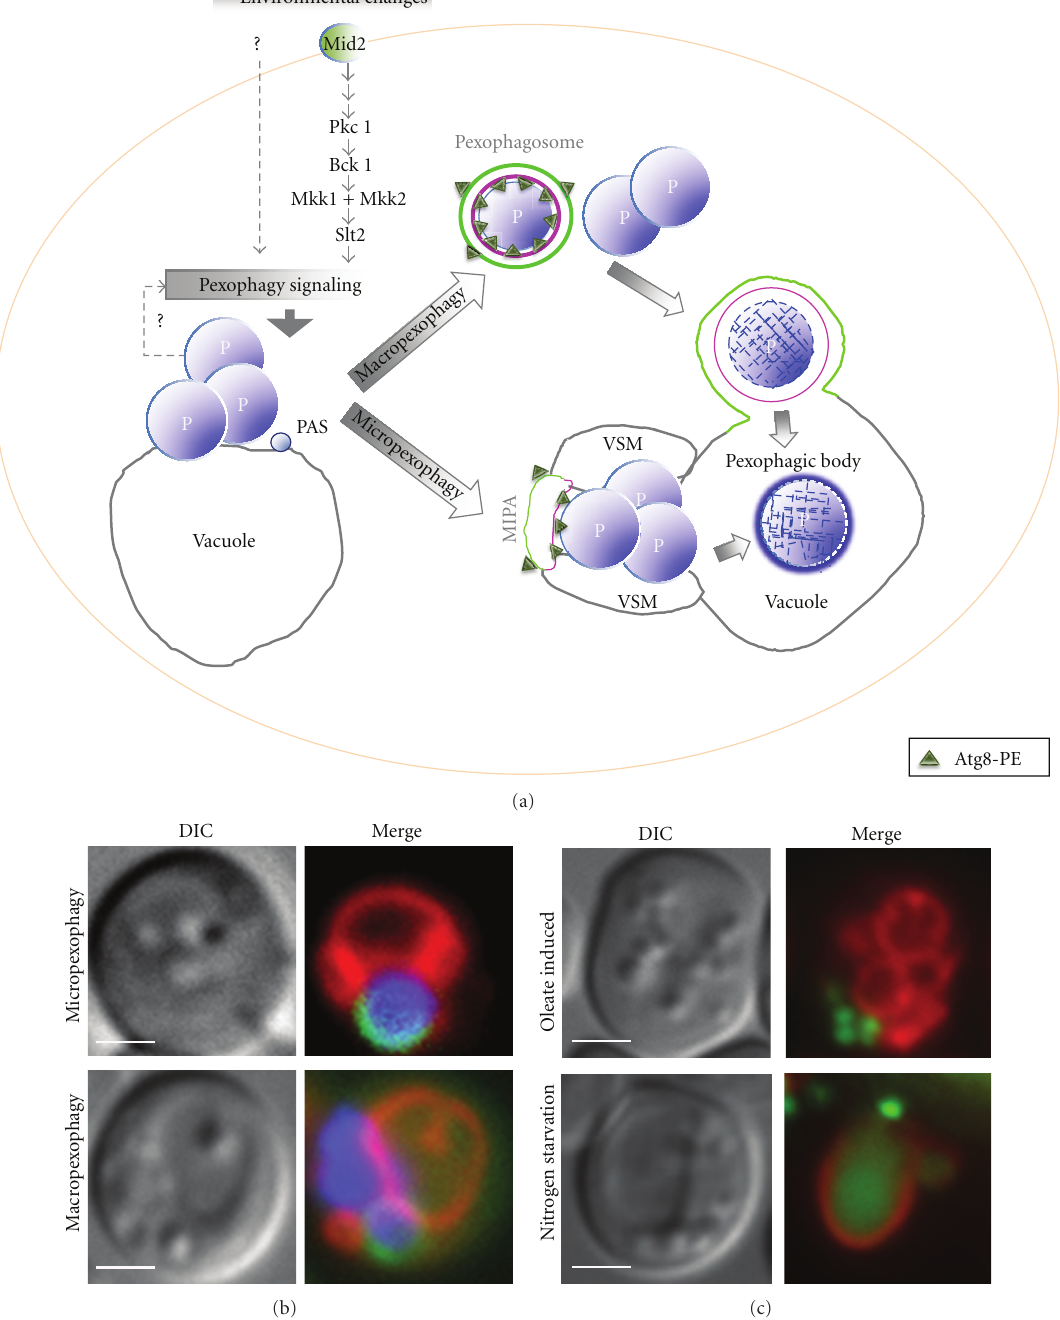
Figure 4: Micropexophagy and macropexophagy. (a) Micropexophagy di ff ers from macropexophagy in vacuole dynamics and formation of the MIPA instead of the pexophagosome. A pexophagy-specific PAS, required for both forms of pexophagy, is characterized by its localization near the peroxisome and also touching the vacuolar membrane. Micropexophagy can target a peroxisome cluster for degradation by vacuole remodeling to form cup-like vacuolar sequestration membranes (VSMs) and a lid-like cover called the MIPA (micropexophagy- specific membrane apparatus). Macropexophagy is characterized by individual sequestration of targeted peroxisomes into a pexophagosome, followed by its fusion with the vacuole for degradation and recycling. Pexophagy signaling is dependent on Mitogen-activated protein kinase (MAPK) pathways (Mid2-Slt2 cascade), but may also be triggered by internal (unknown) factors, including signals related to the status of, or metabolic need for, (e.g., damaged or superfluous) peroxisomes. (b) The upper panel depicts a single P. pastoris cell that has undergone peroxisome induction (in methanol) and has then been switched to micropexophagy conditions (glucose). The vacuole (red, FM 4–64) is shown surrounding the targeted peroxisome cluster (blue, BFP-SKL). The MIPA (green, GFP-Atg8) forms a lid over the cup-like VSMs. The lower panel illustrates pexophagosome formation around a single peroxisome under macropexophagy conditions (ethanol). (c) S. cerevisiae cell labeled with GFP-tagged thiolase (a peroxisome matrix marker) and vacuole marker (FM 4–64, red) shows proliferated peroxisomes under nutrient-rich conditions (in oleate, top panel). When the cells are switched to glucose without nitrogen, peroxisomes are targeted to the vacuole by macropexophagy and GFP accumulates in the vacuole (lower